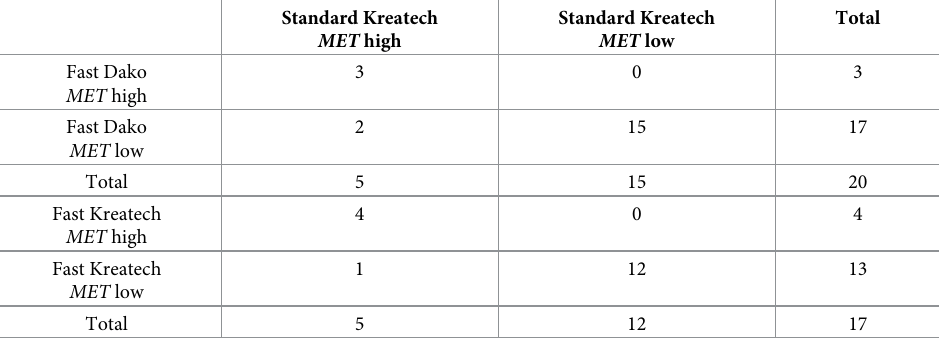
Table 2. Number of cases determined as MET high or MET low using fast Dako and fast Kreatech assays com- pared to the standard Kreatech